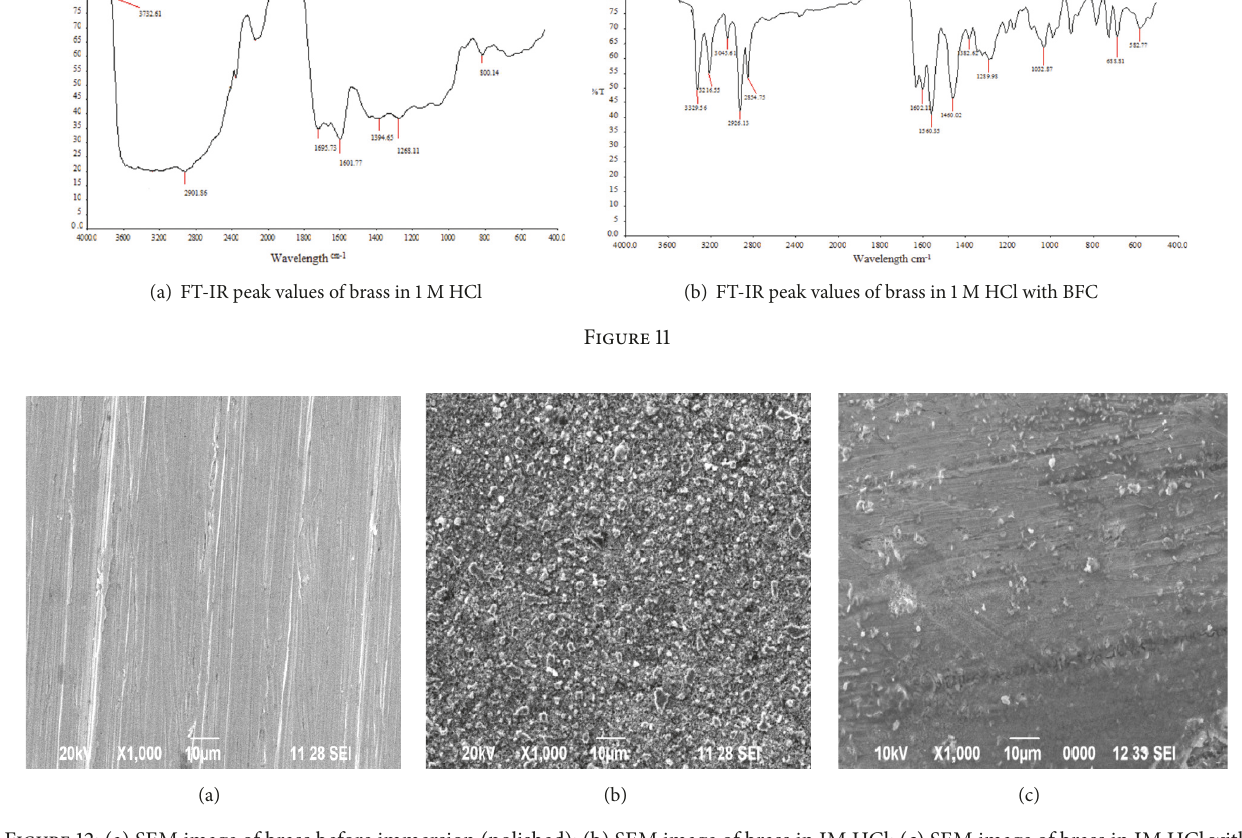
Figure 12: (a) SEM image of brass before immersion (polished); (b) SEM image of brass in IM HCl; (c) SEM image of brass in IM HCl with